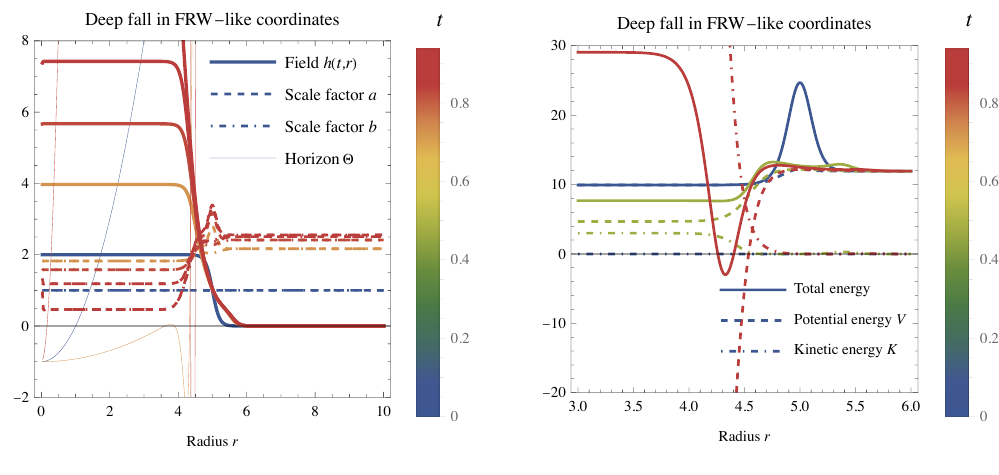
Figure 5 . As in figure 4, but considering an initially thin